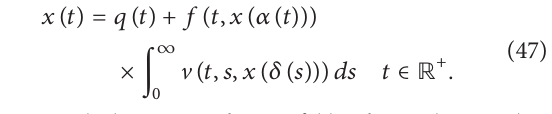
so 𝑘(𝑡, 𝑠) = 1/(1 + 𝑡 4 + 𝑠 2 ) , 𝑝(𝑡, 𝑠) = (1/4)𝑒 −𝑠𝑒 𝜓(𝑥) = 𝑥 , and then (𝐻